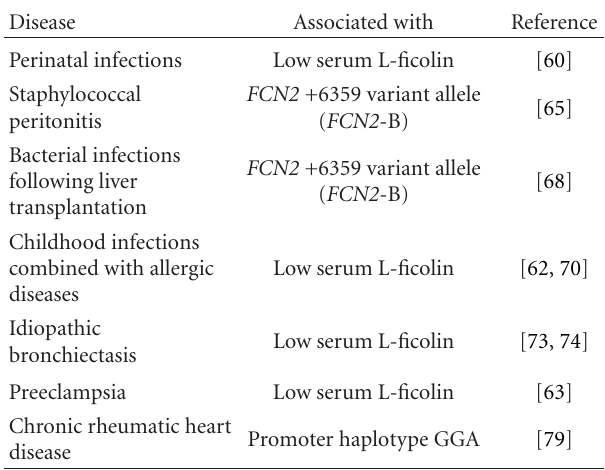
Table 3: Some disease associations of L-ficolin insu ffi ciency.